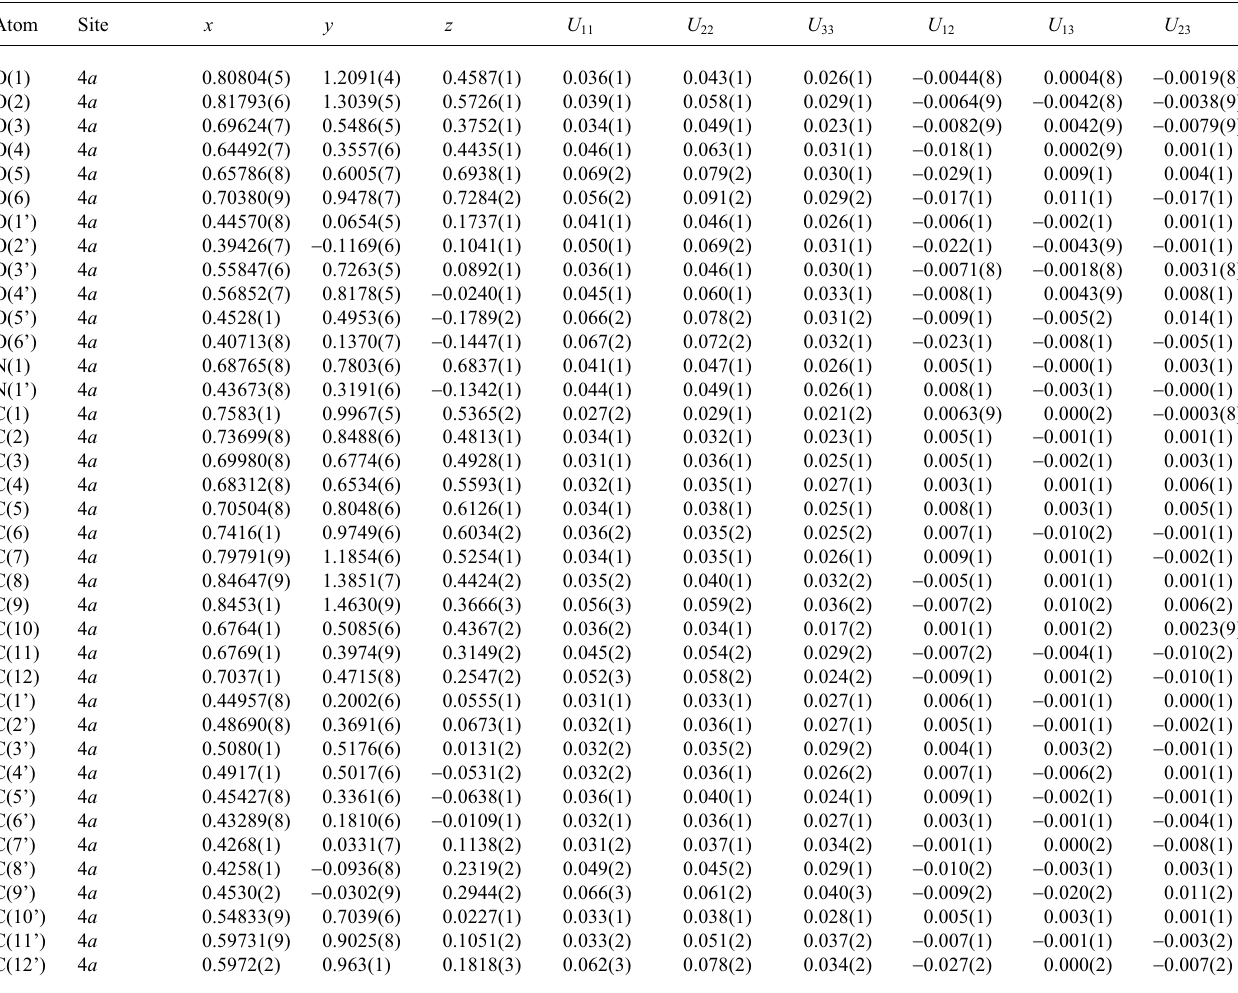
Table 3. Atomic coordinates and displacement parameters (in Å 2 )